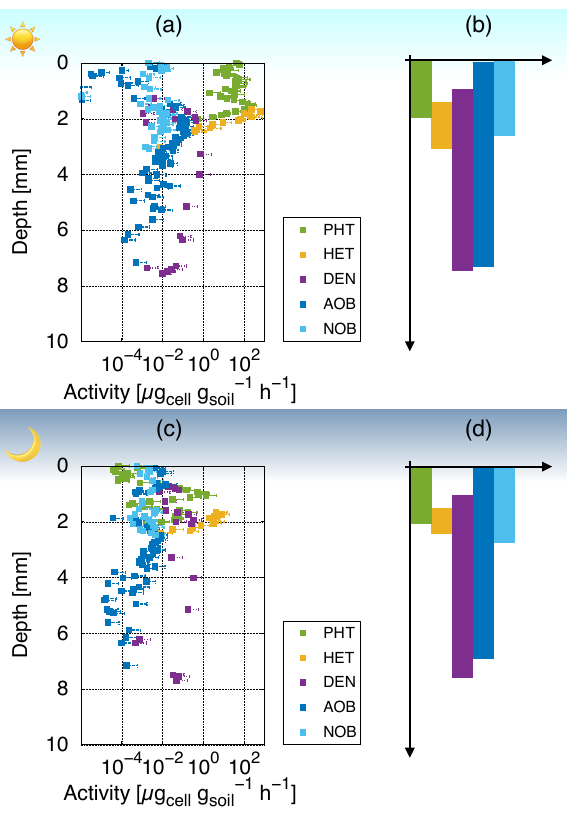
Figure 7. Diurnal variations in microbial activity within saturated biocrusts. Simulated microbial activity profiles and vertical strati- fication at midday (a) and midnight (c) . The spatial distribution of microbial activity is averaged with respect to the horizontal direc- tion for 10 independent simulations (only upper SDs ( + 1SD) are shown considering the log scale). (b, d) Based on the vertical distri- bution of microbial community members, the depth containing the activity of each microbial group within the biocrust is marked by the bars (with respective colour